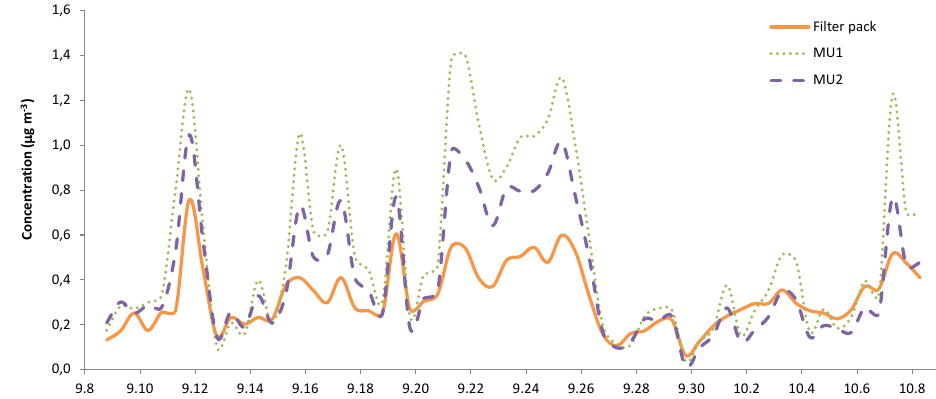
Figure 6. Filter pack and MU measured NO − Fig. 6. Filter pack and MUs measured NO 3- concentrations during the ETV period. 3